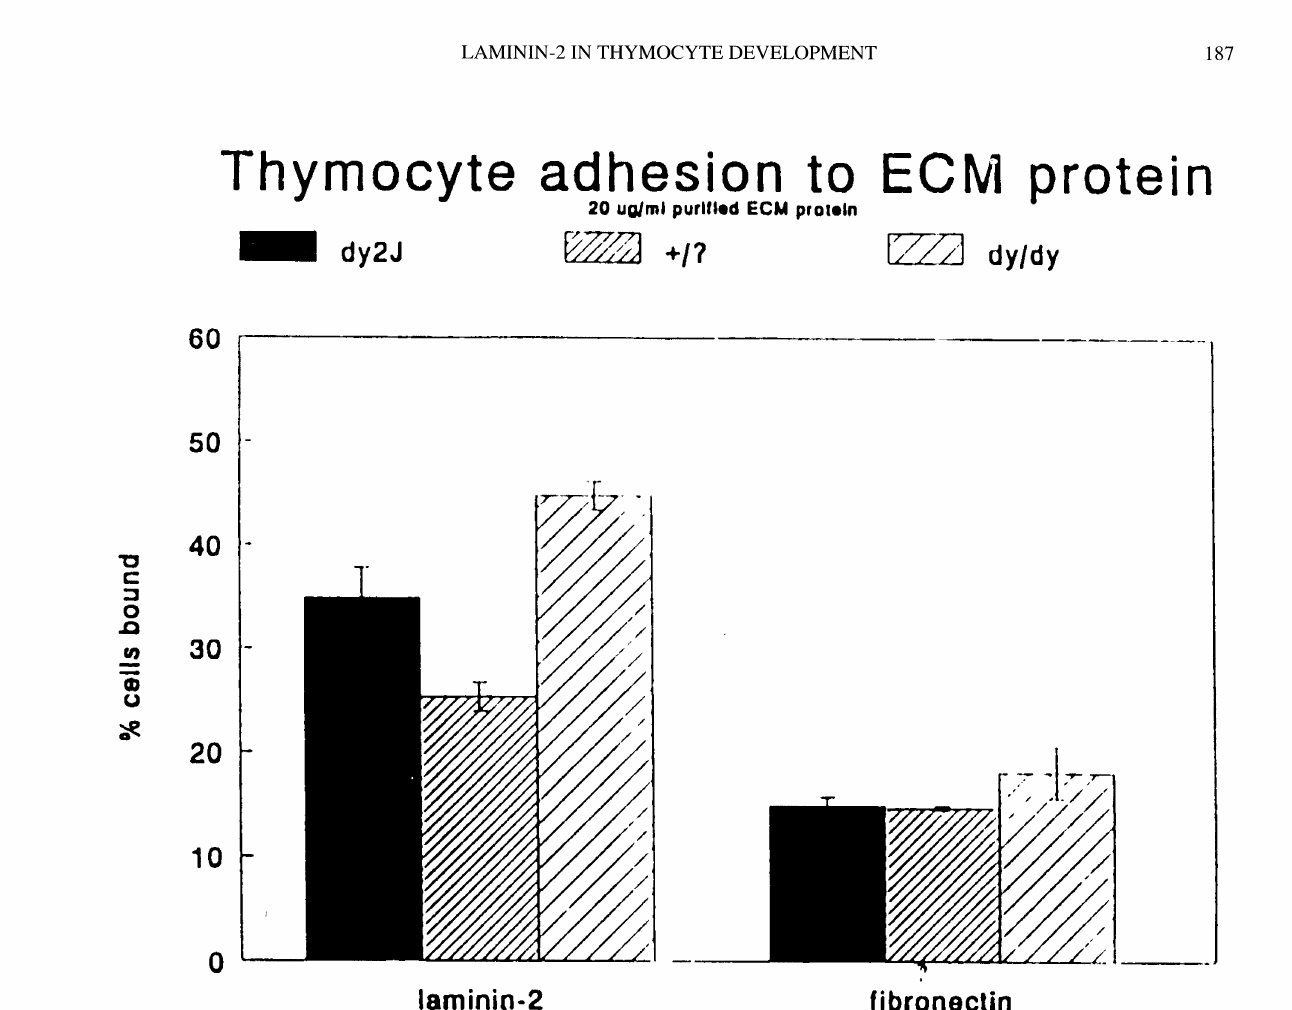
FIGURE 3 Thymocyte adhesion to ECM proteins. To analyze the ability of thymocytes from dy/dy, dy 2J and dy control animals to bind to specific ECM proteins, adhesion assays were conducted on laminin-2 and fibronectin. The assays shown in this figure were conducted with a concentration (20 tg/ml ECM protein) used to coat the wells of the plates which provided maximal binding on each substrate